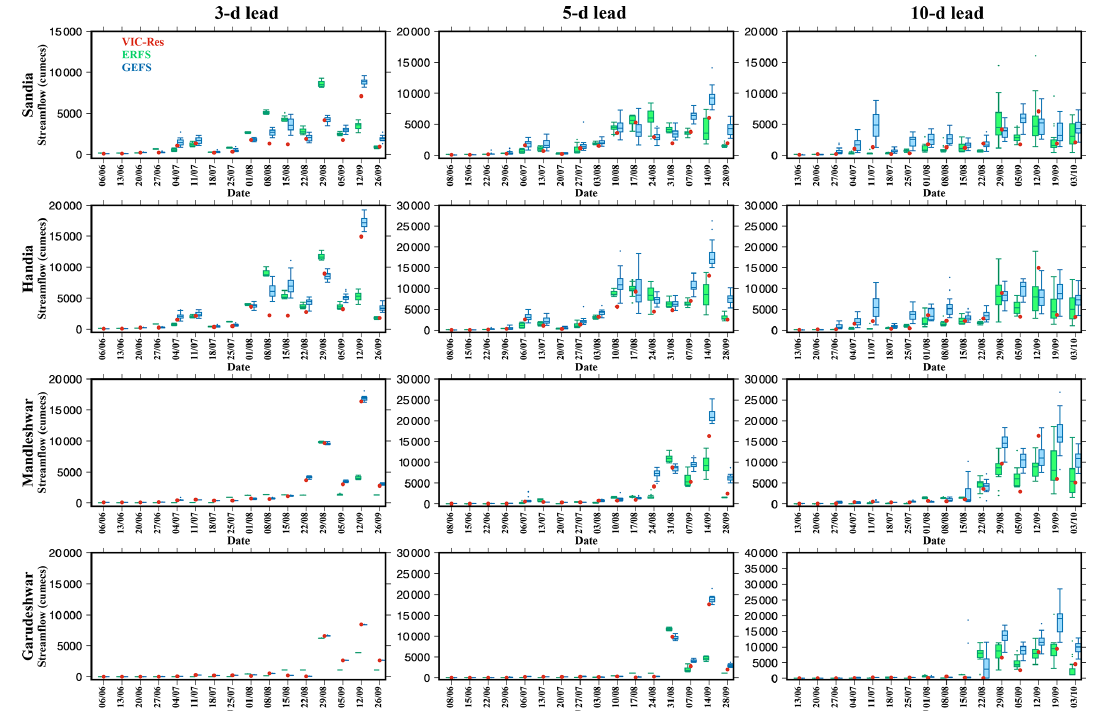
Figure 12. Comparison of ensemble streamflow simulated using the VIC-Res model with ERFS and GEFS forecast products during the summer monsoon of 2019. The forecast skill was evaluated considering the VIC-Res simulated streamflow with the observed forcing from IMD due to unavailability of observed